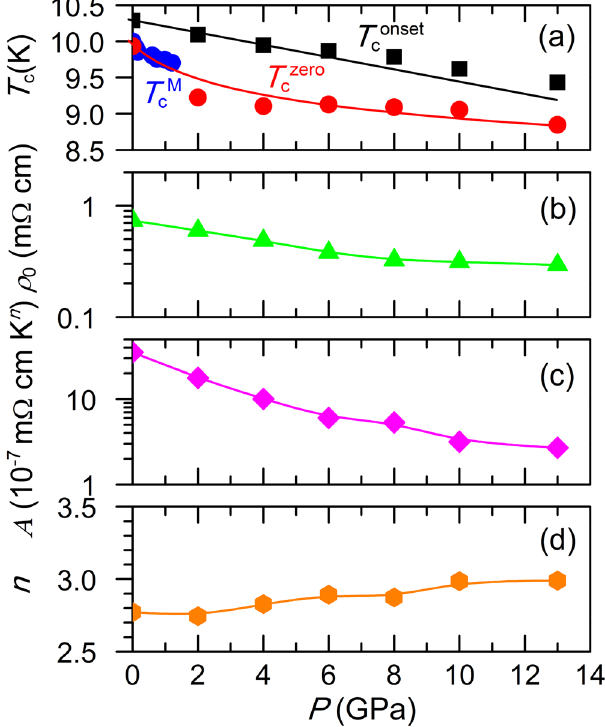
Fig. 4 Measured transport parameters under pressure. Pressure ( P ) dependence of superconducting transition temperature a , and resistivity fi tting parameters, ρ 0 and n b –